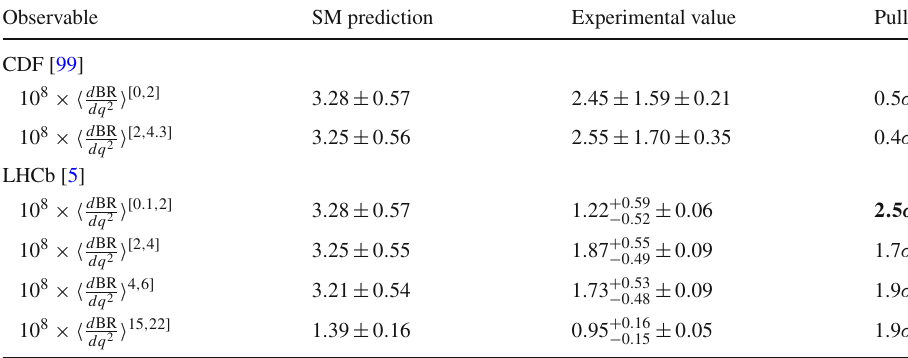
branching ratio of B + → K + μ + μ − included in the global fit